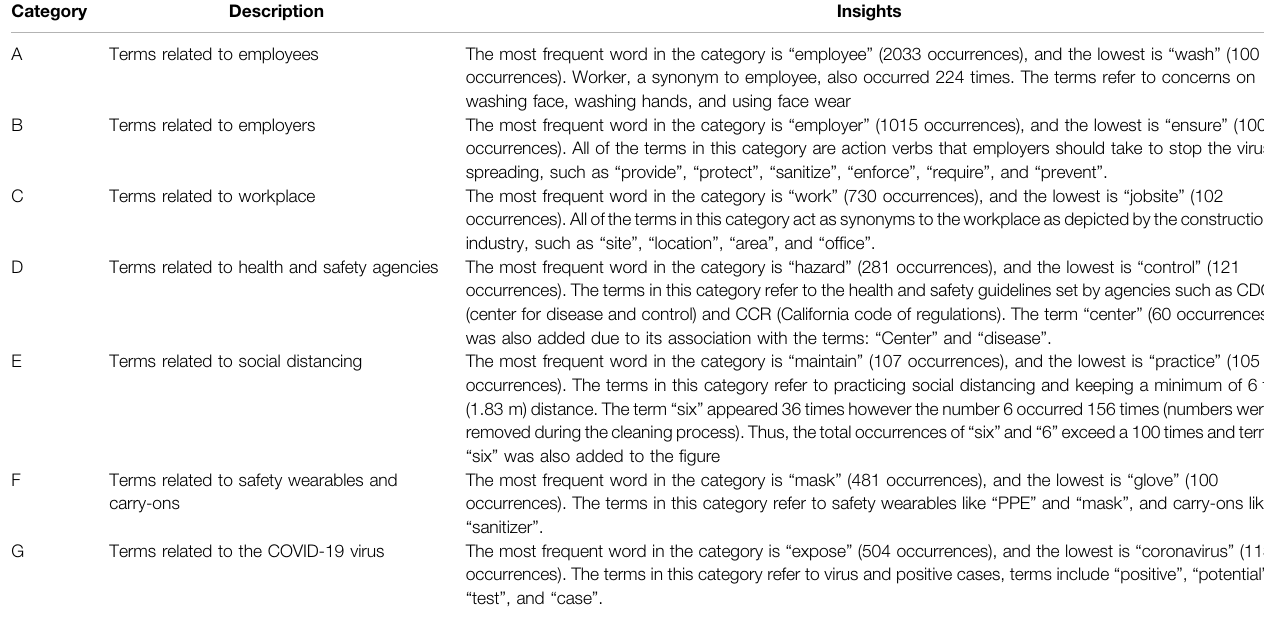
TABLE 2 | Description of categories.